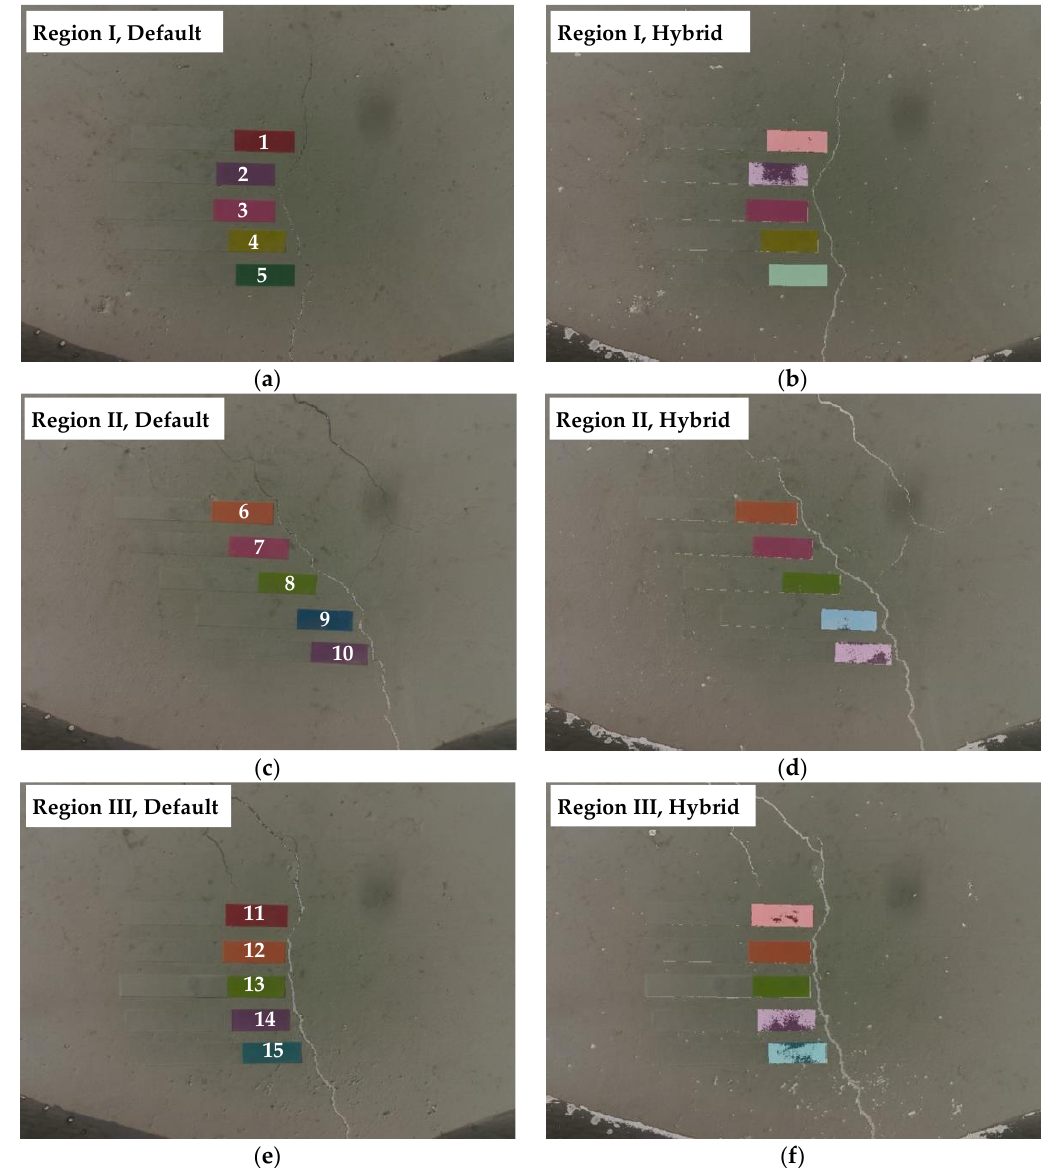
Figure 10. Crack identification results: ( a ) region I, Sauvola’s method with default parameter; ( b ) region I, hybrid method; ( c ) region II, Sauvola’s method with default parameter; ( d ) region II, hybrid method; ( e ) region III, Sauvola’s method with default parameter; and ( f ) region III, hybrid method. Table 3. Comparison of obtained crack lengths.